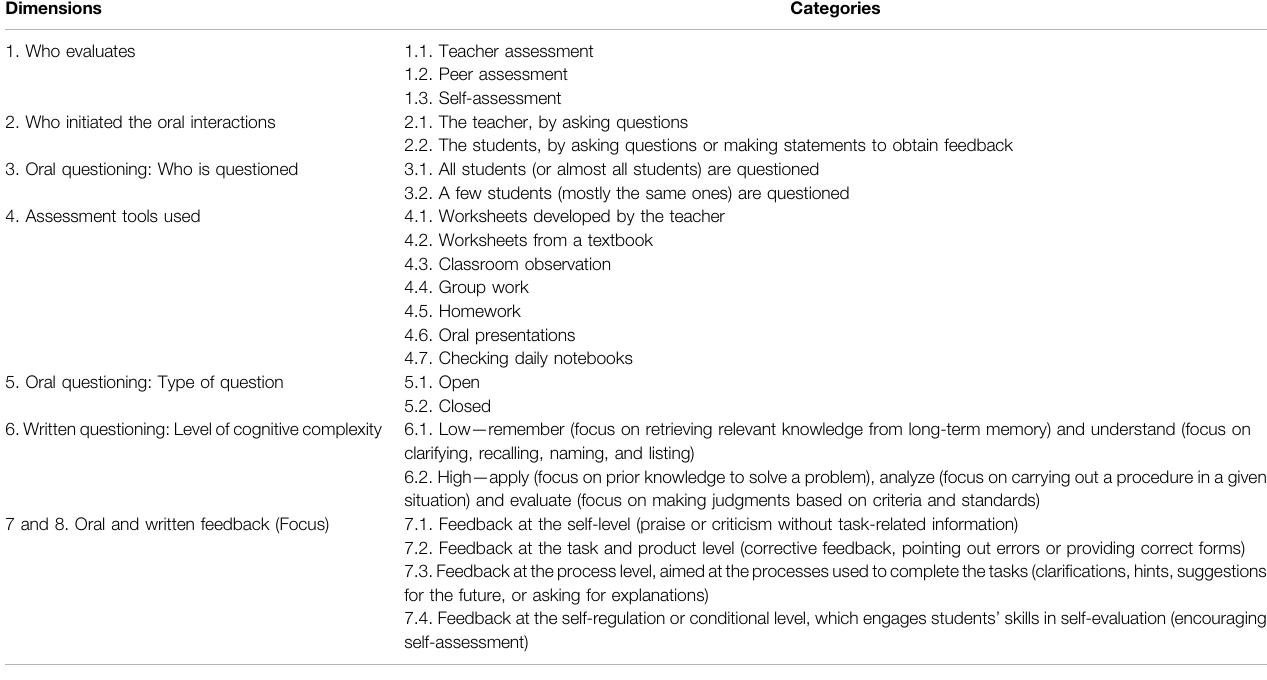
TABLE 3 | Dimensions and categories of analysis for the assessment practices. Dimensions